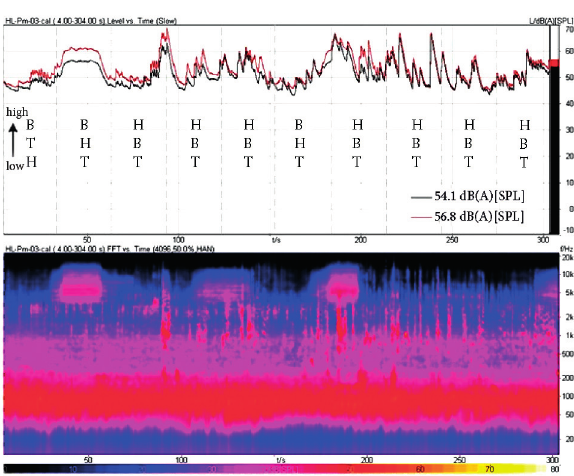
Fig. 2. SPL and spectrum change on site No. 3 in Huli park